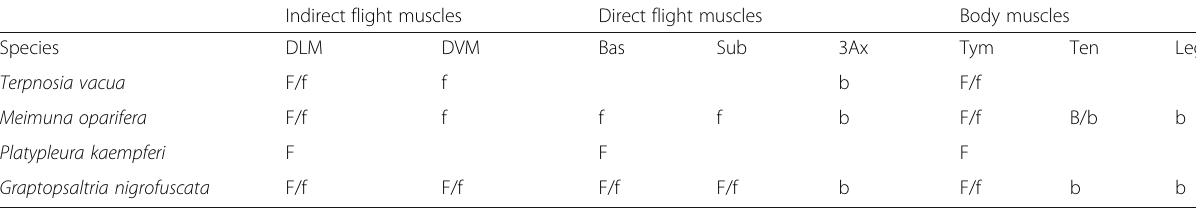
F or f, flight muscle type (1:3 myofilament lattice and sampled 1st layer line, expression of flight muscle-specific troponin I isoform); B or b, body muscle type (1:5 or 1: 6 lattice and non-sampled 1st layer line, lack of flight muscle-specific troponin I isoform). Capital letters, evidence from X-ray diffraction; small letters, evidence from immunoblotting. Bas, basalar; Sub, subalar, Tym, tymbal, Ten,